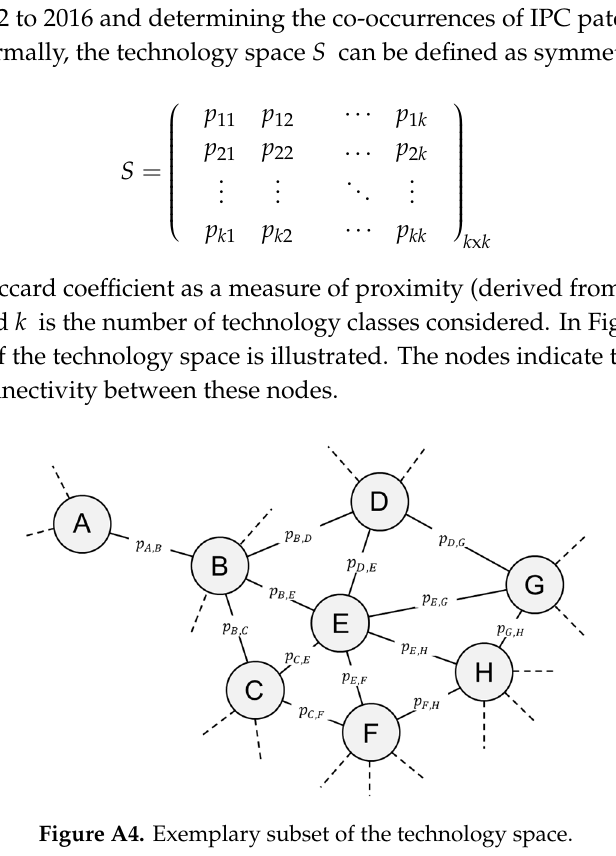
Figure A5. Distribution of patents over runs.